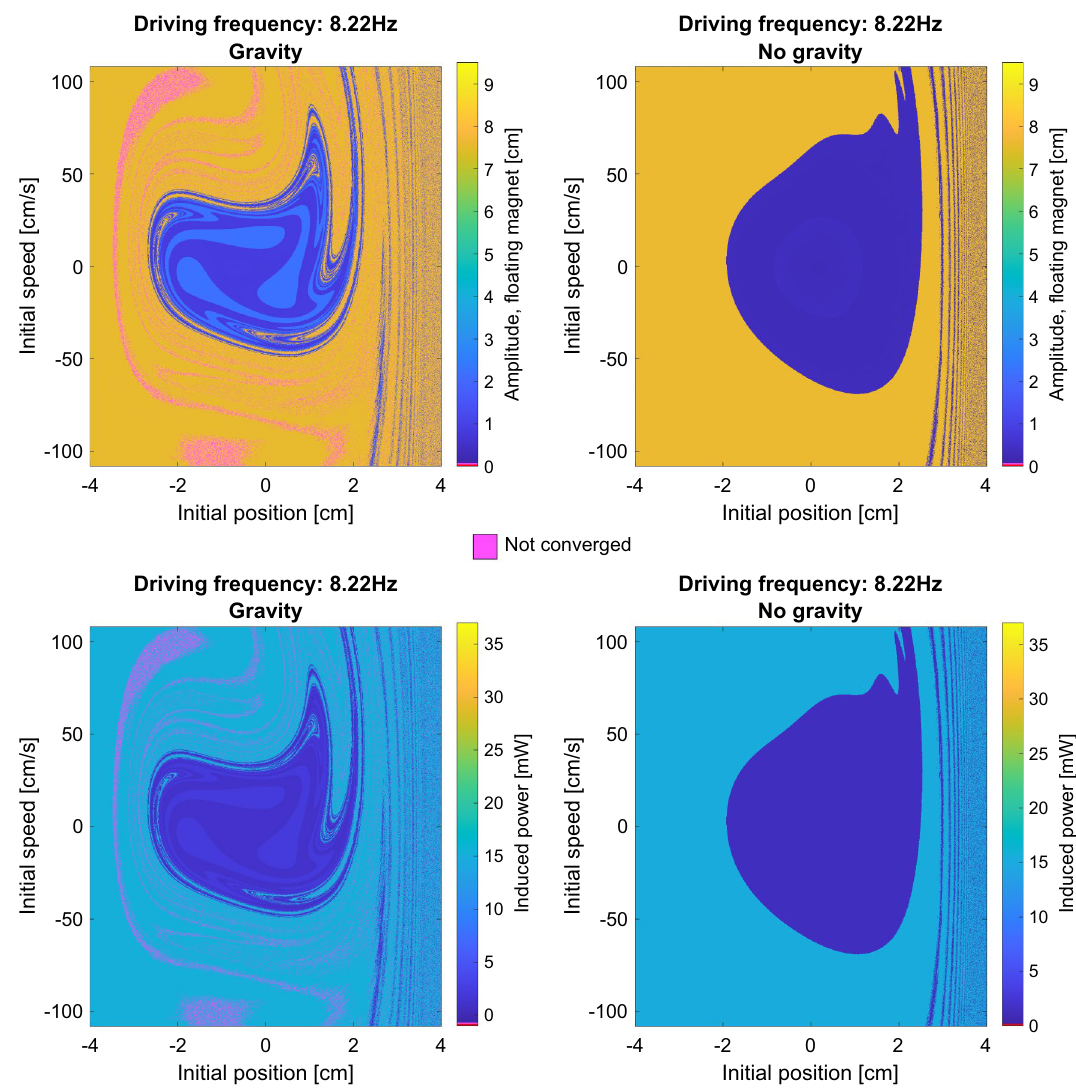
Figure 5. The amplitude of the floating magnet for 8.22 Hz with and without gravity for a range of initial positions and initial speeds and b) the corresponding induced power in the coils. Note that the color pink, which does not appear in the color scale, corresponds to systems that have not converged to a steady state